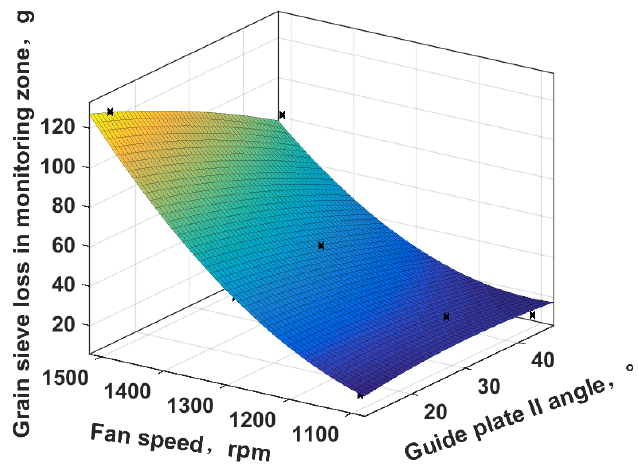
Figure 11. Relationship between sieve loss and working